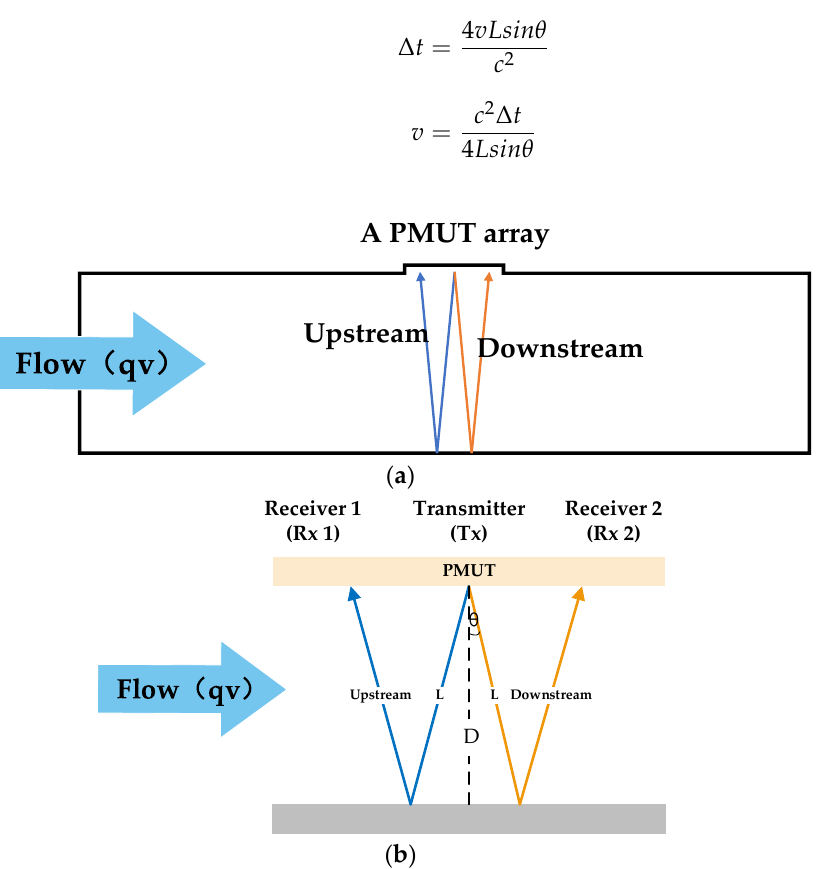
Figure 1. Schematic of the proposed flow sensor. ( a ) Schematic diagram of the flow sensing system pipe. ( b ) Schematic diagram of ultrasound transmitting and receiving in the pipe.